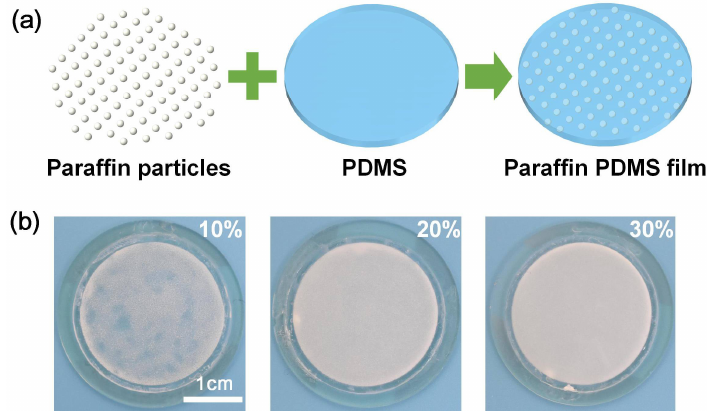
Figure 2. ( a ) Schematic of fabrication of a paraffin-PDMS film. ( b ) Picture of paraffin-PDMS films with concentrations, 10%, 20%, and 30%.